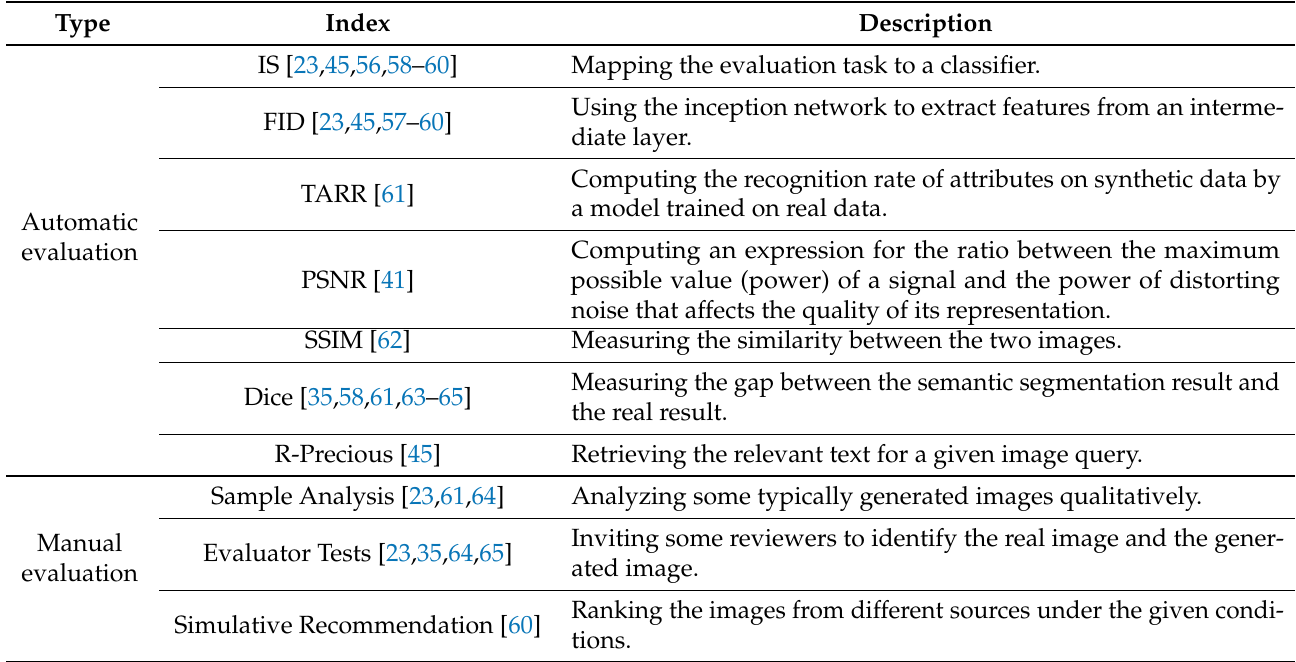
Table 3. A summary of various evaluation